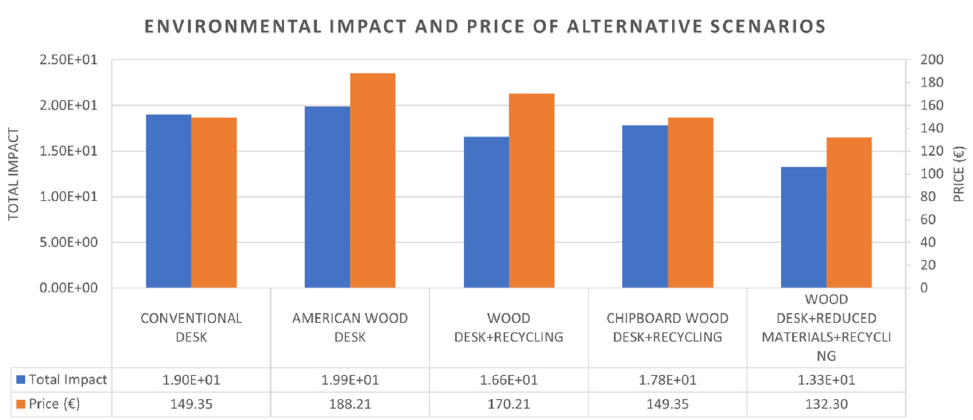
Figure 6. Environmental impact and price of alternative scenarios analysed.